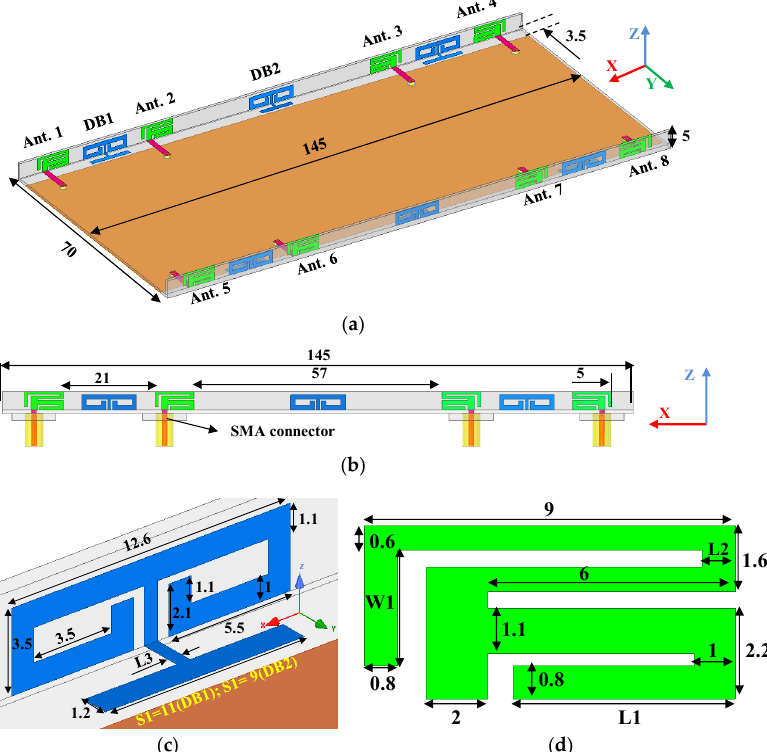
Figure 1. Perspectives of the proposed antenna. ( a ) Overall view, ( b ) side view, ( c ) dimensions of DB1 and DB2, and ( d ) detailed structure of an antenna element. (All values are in millimeters).